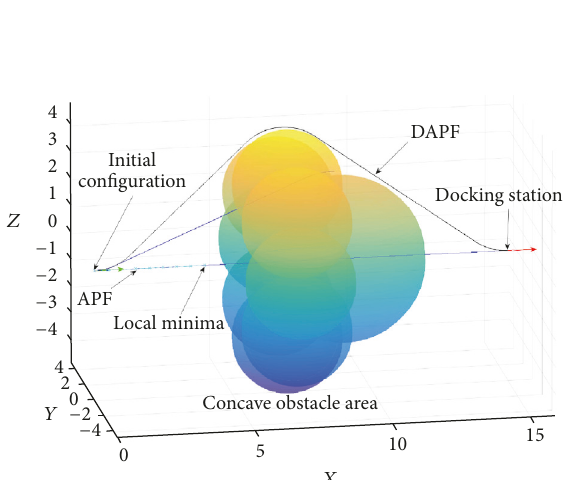
Figure 7: Scenario 2: path planning for docking in environment with concave